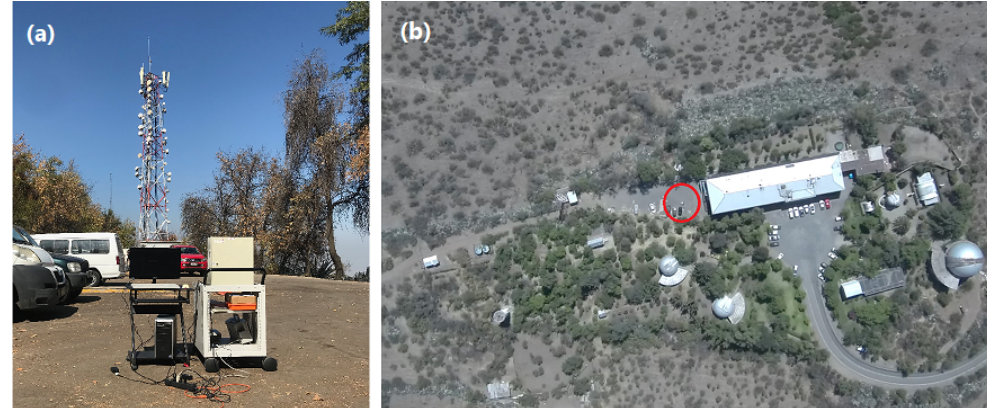
Figure 5. Image of the distance calibration procedure, which uses a UAV as target and the internal GPS of the UAV to estimate its height. ( a ) The radar setup in the Astronomy Campus at the University of Chile (33 ◦ 23 (cid:48) 48 (cid:48)(cid:48) S, 70 ◦ 32 (cid:48) 13.3 (cid:48)(cid:48) W). ( b ) Picture taken by the UAV during the